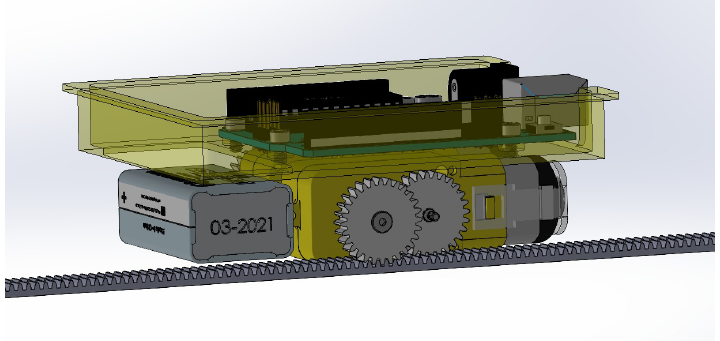
Figure 5. 3D design of Arduino mounted on the gearbox.